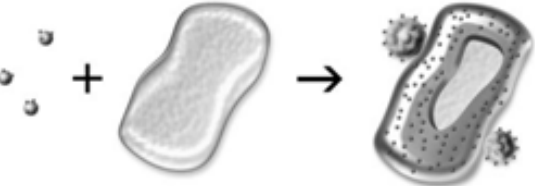
Figure 13. The mechanism of encapsulation of a cell in a metal oxide gel; the coalescence of MTSALs around a living cell with formation of a continuous oxide shell. Reprinted with permission from [37].